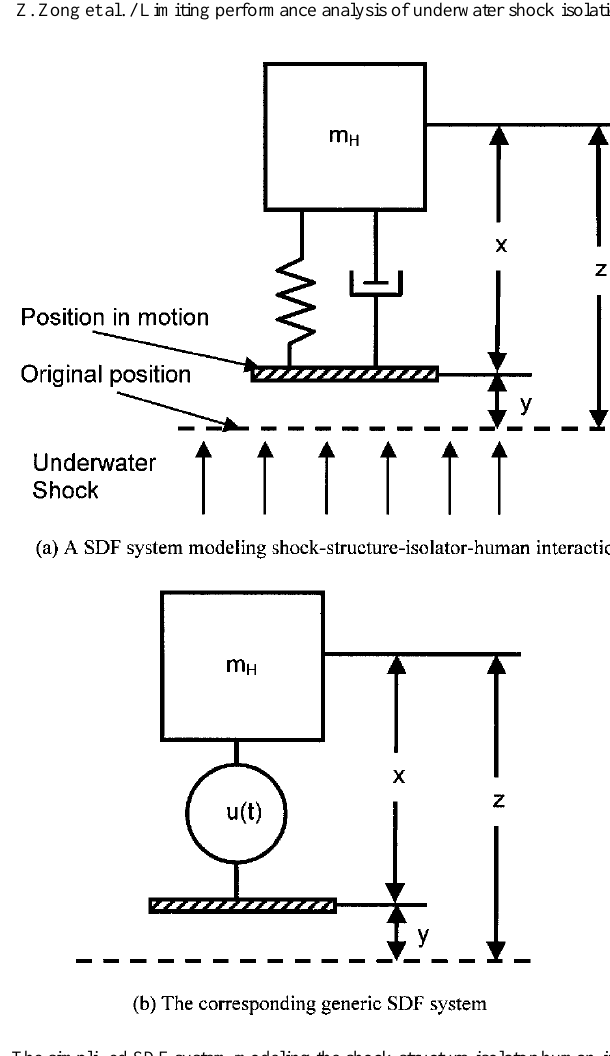
Fig. 1. The simplified SDF system modeling the shock-structure-isolator-human